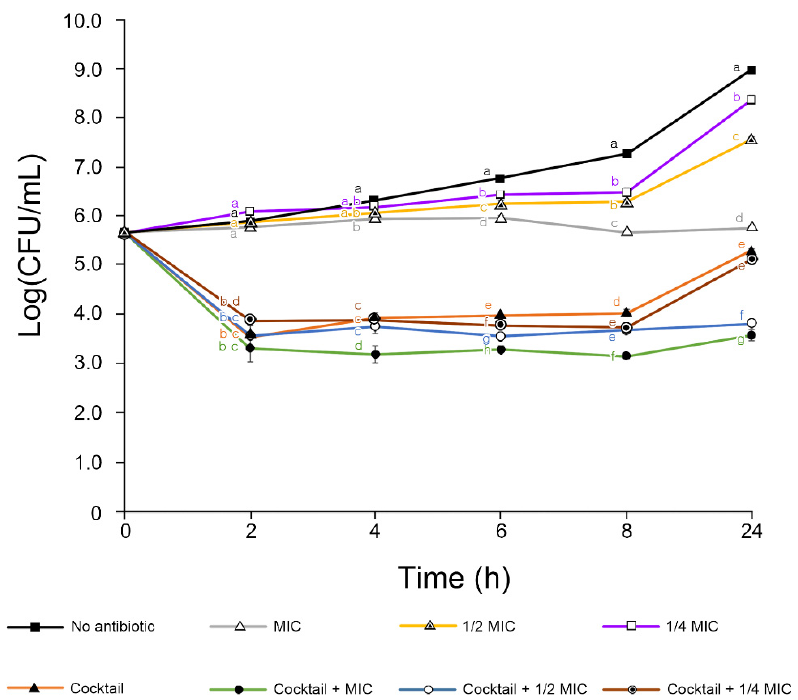
Figure 4. In vitro phage cocktail–antibiotic synergy assay with Erwinia amylovora TS3128. The viable bacterial cells were counted over 24 h. The bars of each point indicate the standard deviation. Statistical significance was calculated using the one-way analysis of variance test with Tukey post-hoc, and the significance threshold was set at p < 0.05. Means at the same sampling time point with different letters (a–g) are significantly different.